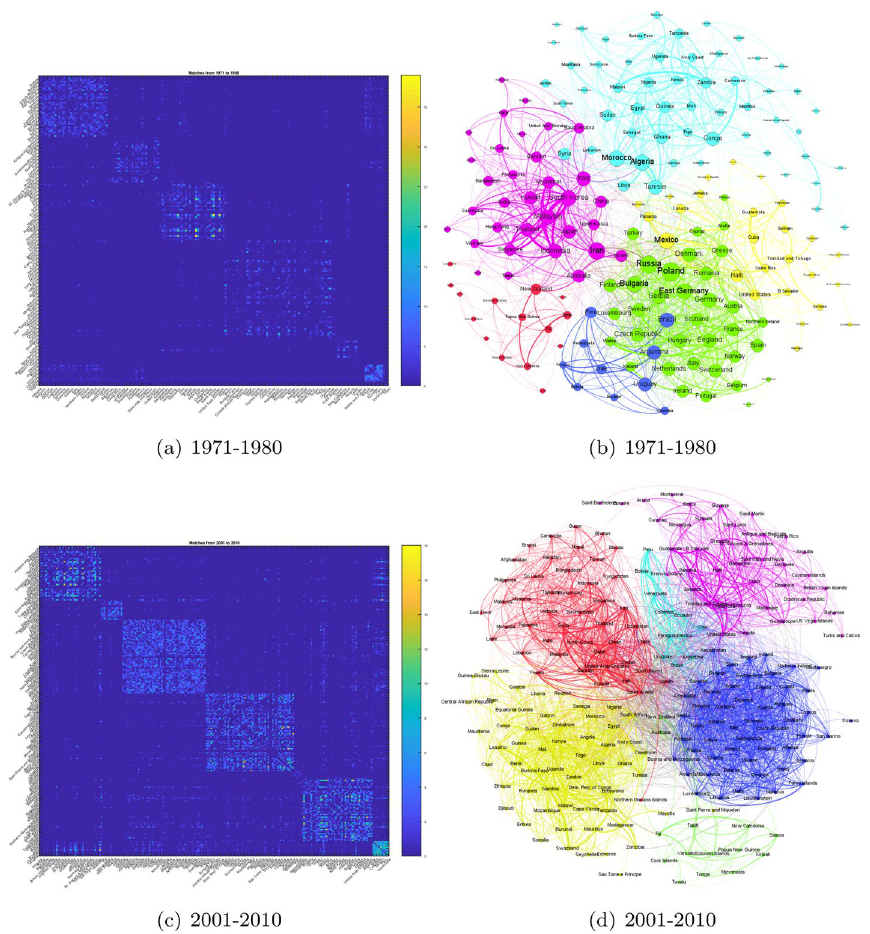
Fig. 11 Adjacency matrices and visualization for decade 1971-1980 and 2001-2010. Left: adjacency matrices. Right: network visualization. Networks get more crowded and complex with more nodes and edges in recent decades, and the community structure is more similar with the modern football landscape represented by the six